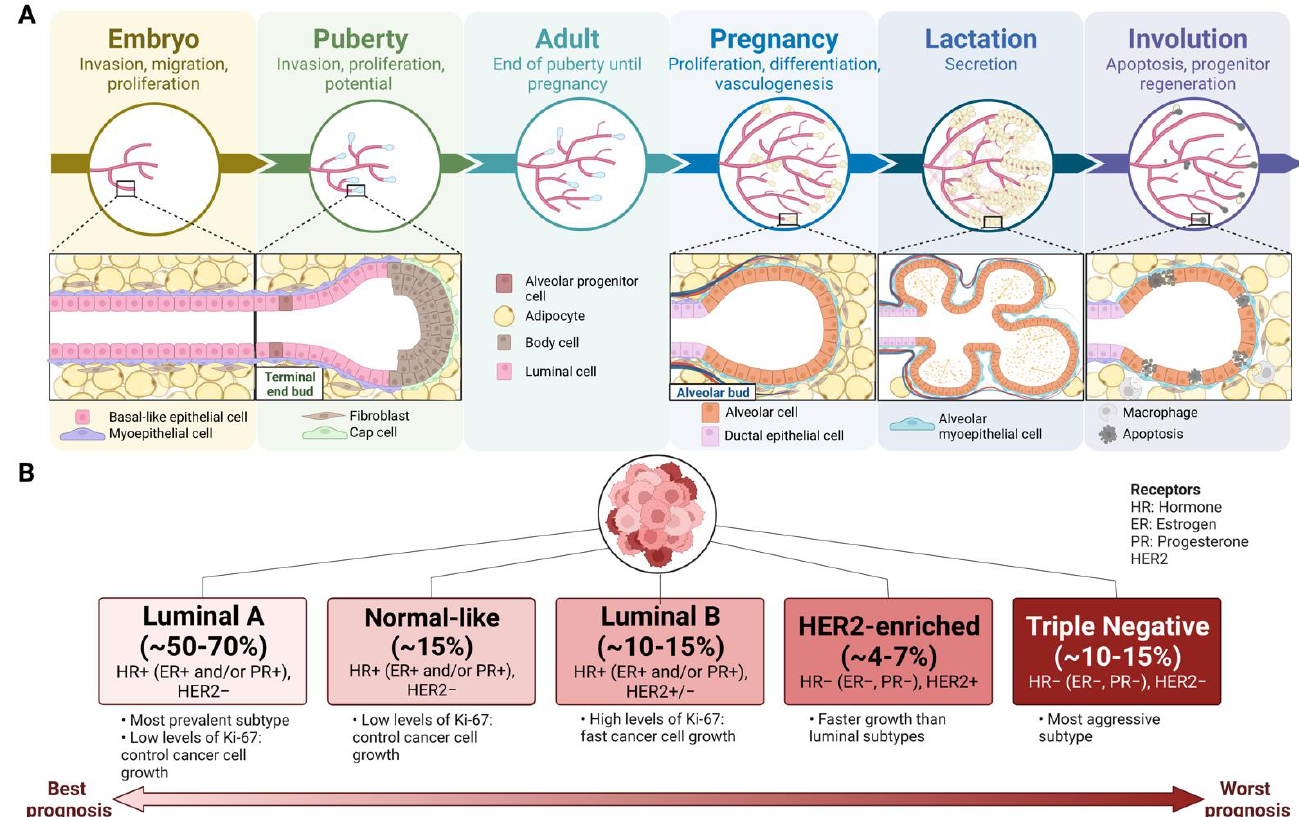
Figure 1. ( A ), A timeline of mammary gland development through six stages and ( B ), Intrinsic breast cancer subtypes, markers, and characteristics from best prognosis to worst prognosis. Cancer type incidence are as per [1,18] Created with BioRender.com.